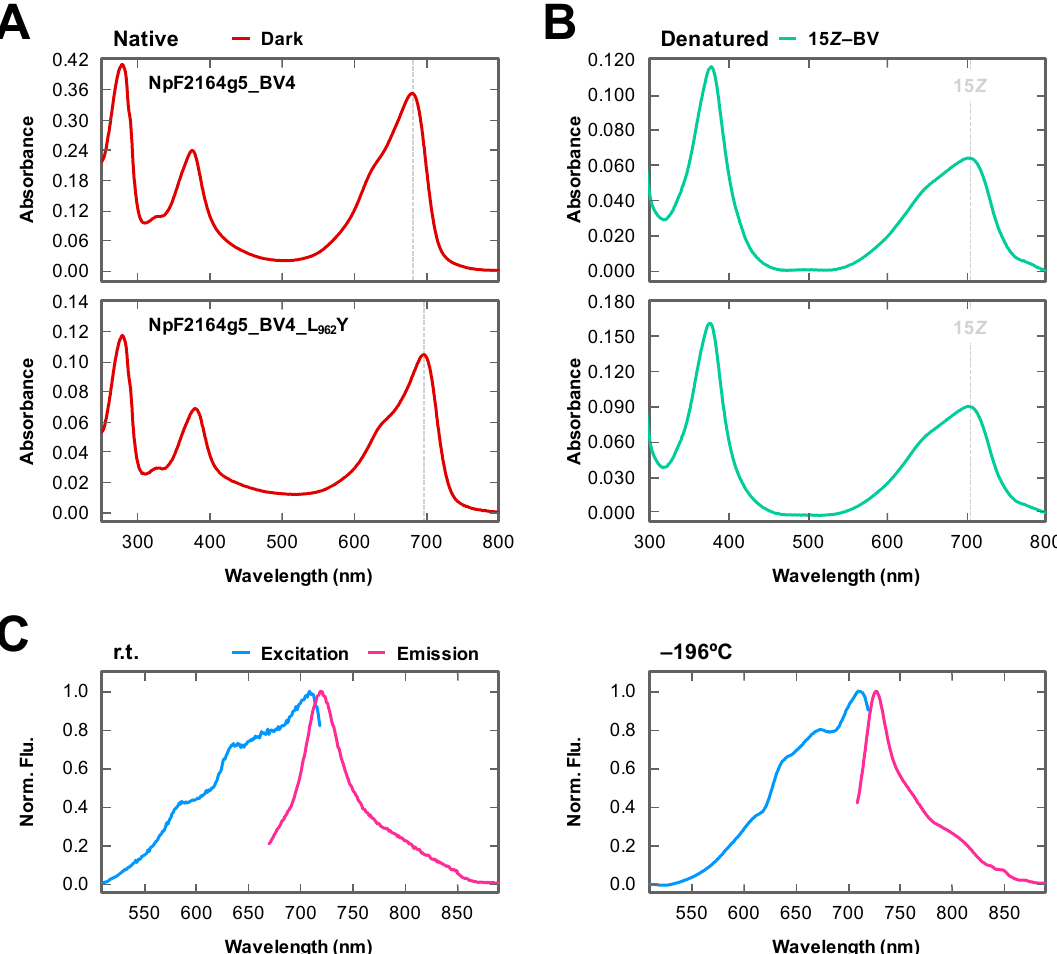
Figure 4. Photochemical properties of BV-bound NpF2164g5_BV4 and BV4_L 962 Y. ( A ) Absorption spectra of NpF2164g5_BV4 ( upper panel) and BV4_L 962 Y ( lower panel) in dark states (Pfr forms, dark red) under native conditions. These native spectra were recorded at r.t. Each peak of the Pfr form was indicated by dotted line. ( B ) Absorption spectra of NpF2164g5_BV4 ( upper panel) and BV4_L 962 Y ( lower panel) in the dark states (15 Z forms, light green) under the acid-denatured condition. The acid-denatured spectra were recorded at r.t. and compared with that of BV-bound AnPixJg2_BV4 [25]. ( C ) Normalized fluorescence excitation (cyan) and fluorescence emission spectra (magenta) of NpF2164g5_BV4 (light colors) and BV4_L 962 Y (deep colors). These fluorescence spectra were recorded at r.t. ( left ) and − 196 °C ( right ).